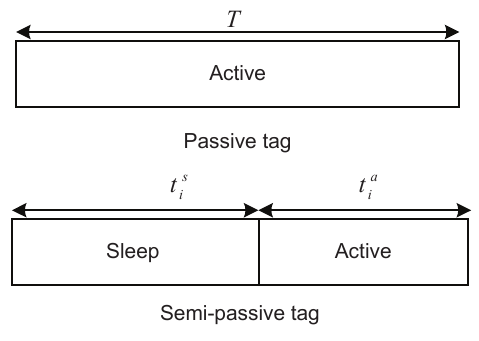
Figure 2. The working model of an activated